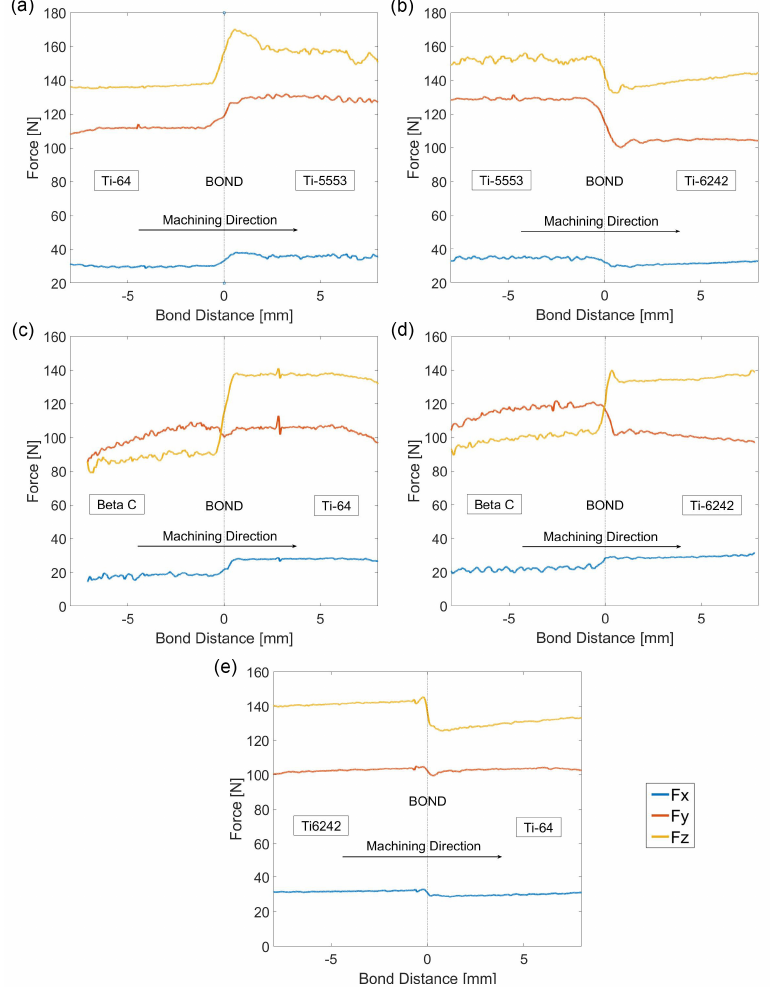
Figure 6. Plots presenting the average machining forces across the diffusion bonds response for Fx, Fy and Fz. ( a ) Ti-64/Ti-5553, ( b ) Ti-6242/Ti5553, ( c ) Ti-64/Beta C, ( d ) Ti-6242/Beta C and ( e )